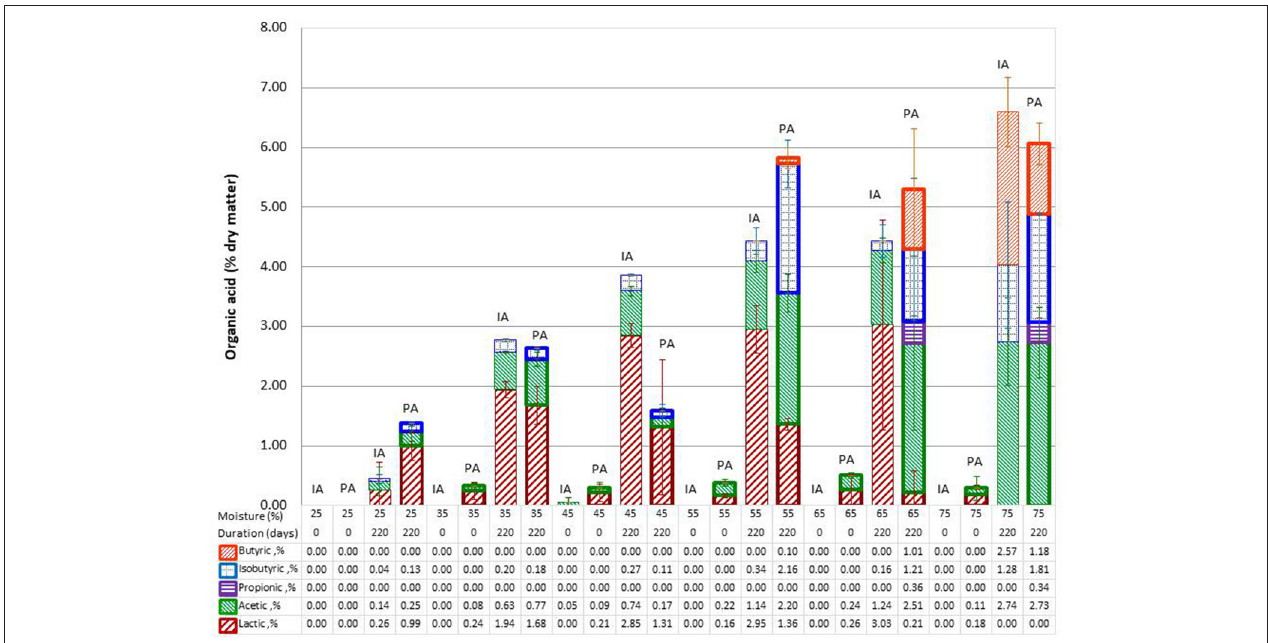
FIGURE 2 | Organic acid profile showing means of IA and PA stover at different moisture levels. Lighter bars are IA samples and darker bars to the right are PA samples. Error bars are standard deviations of mean.